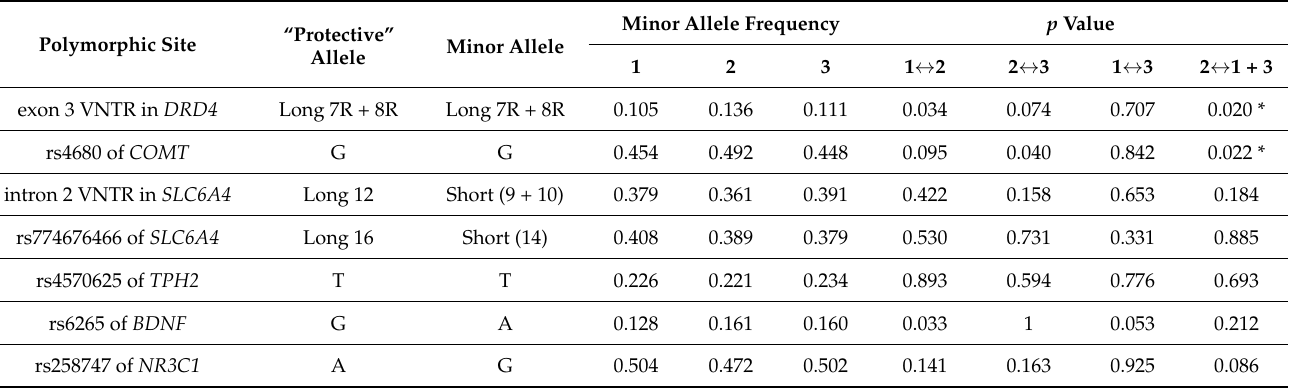
Table 6. Minor allele frequencies of SNPs rs4680, rs4570625, and rs6265; VNTRs in exon 3 of DRD4 ; and VNTRs in intron 2 and indel rs774676466 in SLC6A4 in the studied groups of adolescents (1: